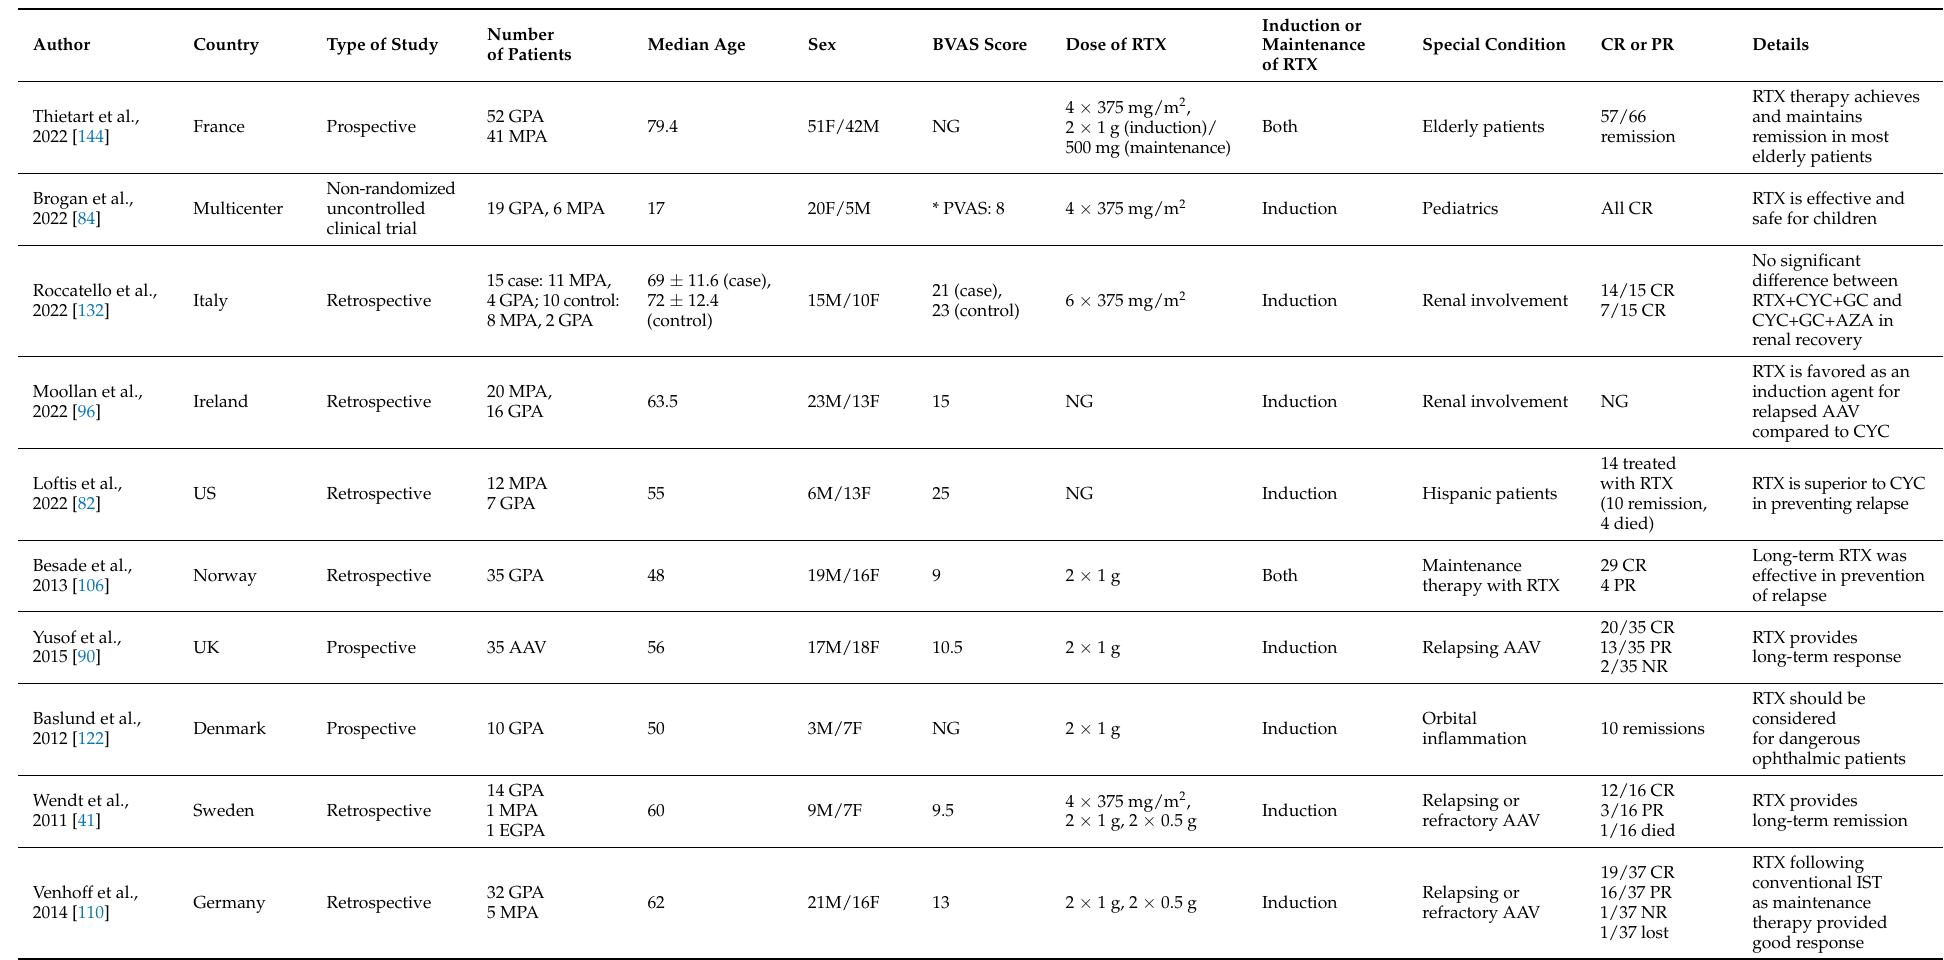
Table 2. Non-randomized studies of RTX therapy in AAV